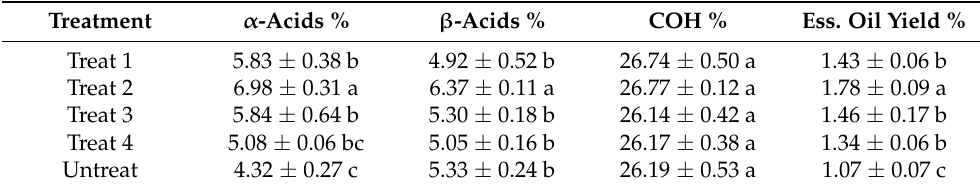
Table 7. Bitter acids ( α - and β -acids) contents (% w/w ) on dry weight, cohumulone (COH) % on the total of alpha acids, and essential oil yield % v/w . Values followed by the same letter indicate no significant difference ( p < 0.05). Treatment α -Acids